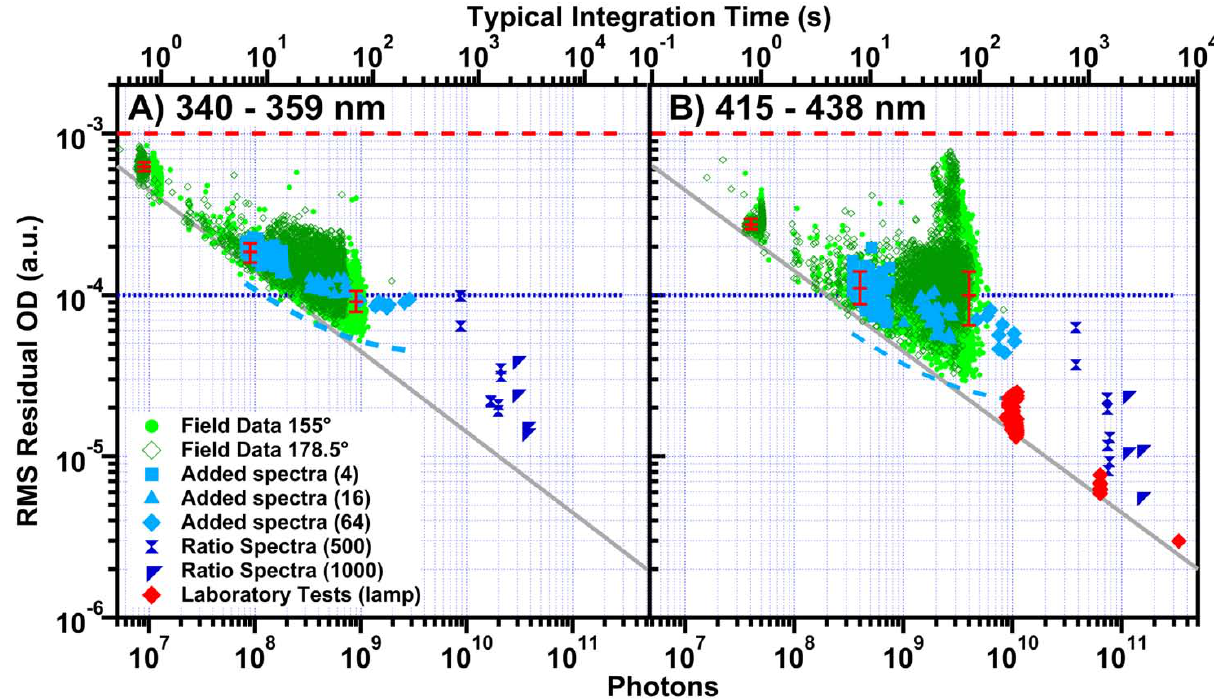
Fig. 5. Comparison of experimental and theoretical RMS noise vs. photon counting statistics for data collected between 3 March and 25 May 2010, July 2010, and April 2011. (A) For the BrO evaluation range (340–359nm). (B) For the IO evaluation range (415–438nm), except for the laboratory tests with a tungsten lamp which were analyzed between 440–465nm. Horizontal lines indicate typical RMS values of other MAX-DOAS instruments: (red dashed line) Mini-MAX-DOAS (10 − 3 RMS); (blue dotted line) research grade MAX-DOAS (10 − 4 RMS). Actual field measurement data is depicted for the 155 ◦ and 178.5 ◦ viewing angles, (solid light green circles and open dark green diamonds, respectively) from the spring 2010. Field tests from the July 2010 period are depicted with the blue markers. Light blue indicates only co-added spectra (155 ◦ elevation angle): 4 spectra (squares), 16 spectra (triangles), and 64 spectra (diamonds). Dark blue indicates co-added ratio spectra (155 ◦ elevation angle): 500 ratios (hourglasses); 1000 ratios (triangles pointing up and to the left). The laboratory tests are the red diamonds. The theoretical noise for all the measurement scenarios are the gray horizontal line and the light blue horizontal line. The light blue lines were calculated with a fixed count number for the reference, which was 4 × 10 9 photons, while the grey line was calculated assuming the same number of photons in the analyzed and reference spectrum. The red horizontal lines represent the median values for the field measurements with the whiskers containing the 25th and 75th percentile. The top x-axis reflects typical integration times to collect the corresponding number of photons (on bottom x-axis) for this instrument, which was calculated based on a typical value for the 60s data of 8 × 10 8 and 3 × 10 9 photons in the UV and visible regions,